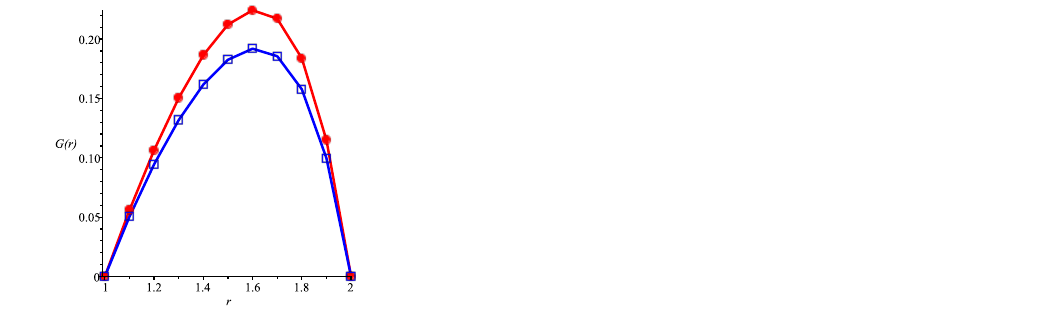
Figure 5. Function G ( r ) for 1 ≤ r ≤ 2, when b = q = θ = 1, k 1 = 1, k 2 = 2, and λ = 1 (with the squares) and λ = 0 (with the circles).